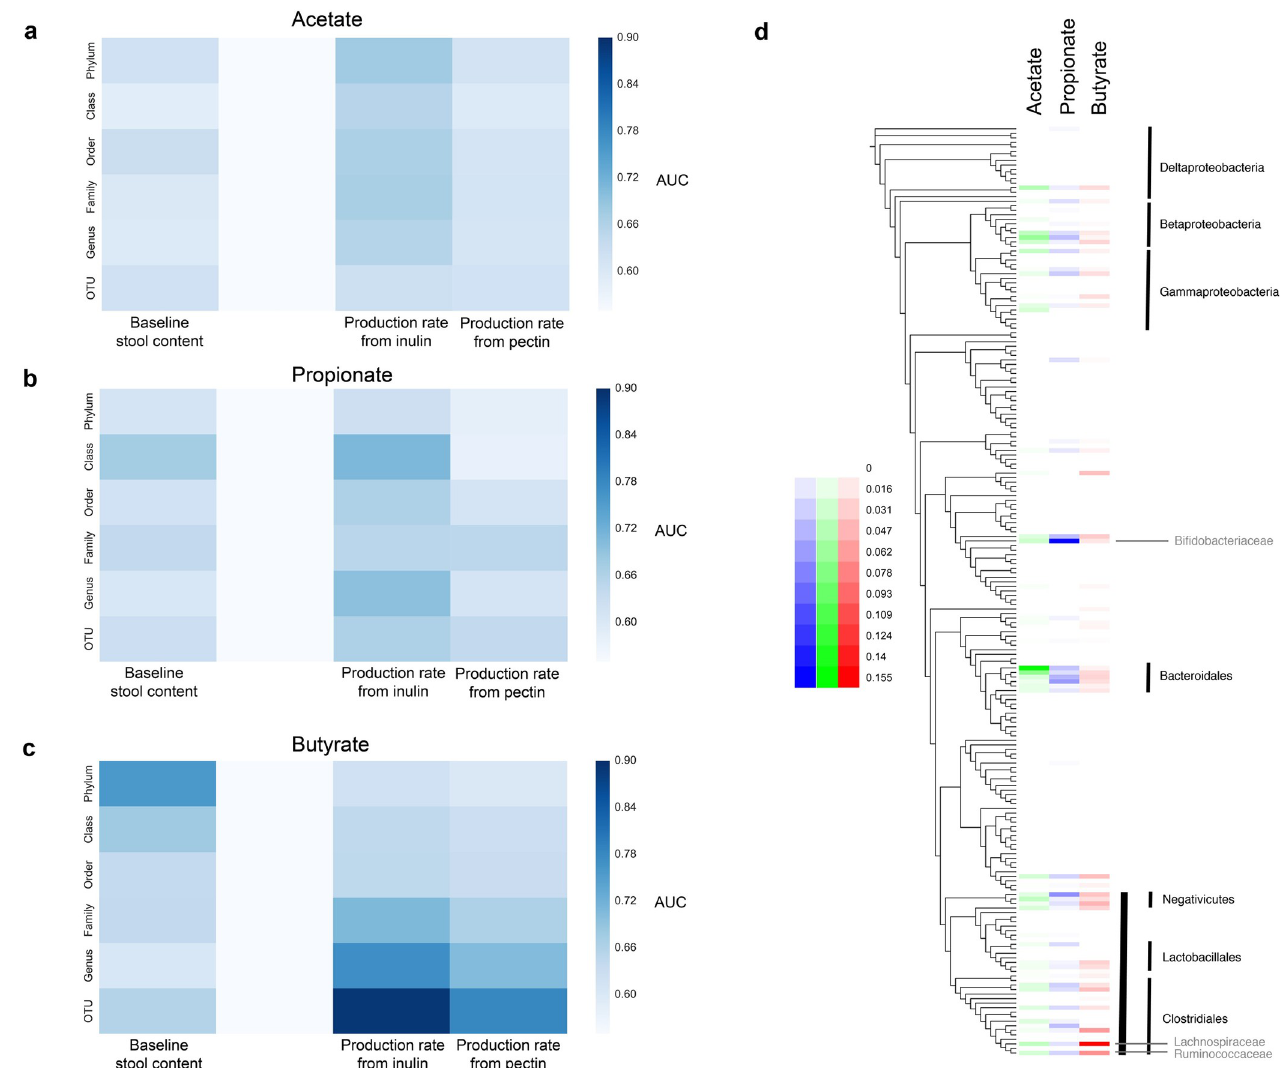
Fig 2. SCFA production capacity can be predicted from individual bacterial OTUs. (a) AUC values for different RFCs trained either to predict high or low SCFA content in stool at baseline, or high or low SCFA production rate ex vivo in response to specific dietary fibers. High and low production is defined according to the z-score across all participants in the study. (b) Relationship between propionate and butyrate production rates, and the relative abundance of an unassigned OTU of the Lachnospiraceae family, showing a relationship between its relative abundance and butyrate production in response to inulin, specifically. (c) Similar relationship but specific to the relative abundance of a Prevotella copri OTU and propionate production in response to inulin. (d) Feature importances from RFCs trained to predict high or low SCFA production in response to inulin from bacterial family abundances.